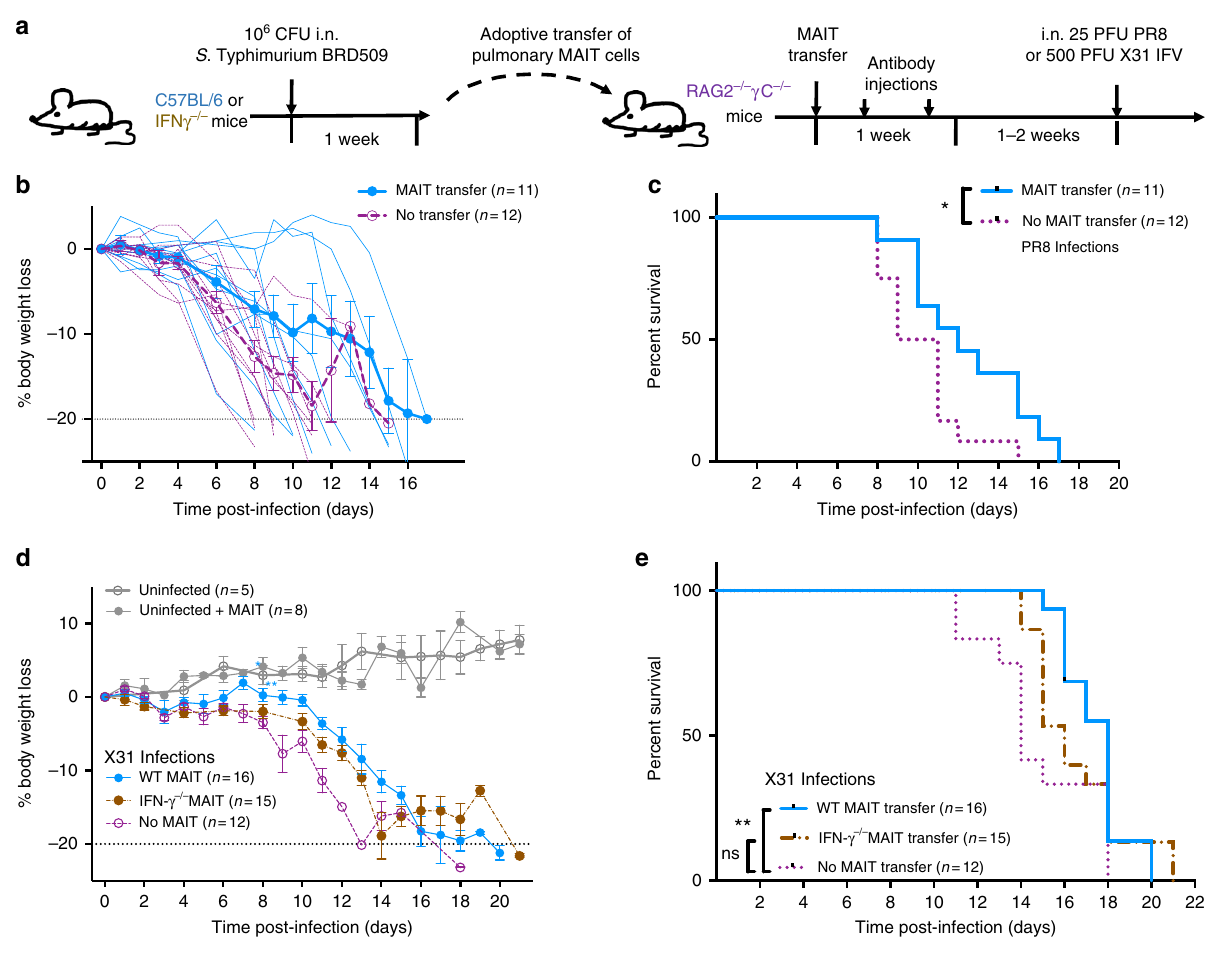
Fig. 4 Adoptive transfer of MAIT cells delays mortality in Rag2 − / − γ C − / − mice with IAV infection. a Schematic of protocol: 3 × 10 5 pulmonary MAIT cells from C57BL/6 mice (previously infected with 10 6 CFU S. Typhimurium BRD509 for 7 days to expand the MAIT cell population) were sorted and transferred intravenously into Rag2 − / − γ C − / − mice, followed by intraperitoneal anti-CD4 and anti-CD8 antibody injection (0.1 mg each) twice within 1 week to deplete any residual conventional T cells included in the transfer. After 2 weeks, mice were infected i.n. with 25 PFU of PR8 ( b + c ) or 500 PFU of X-31 ( d + e ). b Body weight loss expressed as a percentage (showing mean ± SEM and individual values for all mice), and c survival after infection with 25 PFU PR8 virus. Survival curves compared using log-rank (Mantel – Cox) tests. d Body weight loss expressed as a percentage (mean ± SEM), after